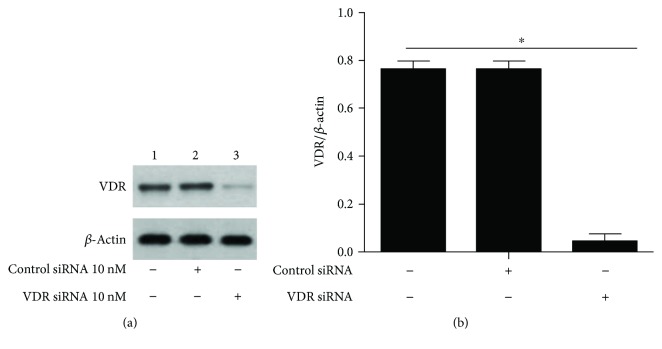
siRNA-mediated VDR knockout in HUVEC. (a) HUVECs were transfected with either control siRNA (10 nM) or VDR siRNA (10 nM), and VDR expression was measured 72 h later by Western blot. (b) Western blot was quantified, and VDR expression is presented as percentage. ∗p < 0.05, relative to normal cells and cells transfected with control siRNA.